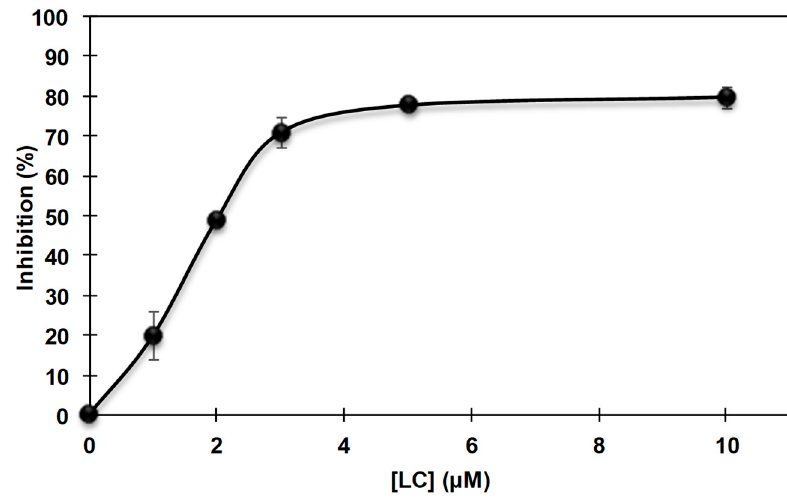
Figure 5. Percent of inhibition of mushroom tyrosinase activity vs. LC concentration using L -tyrosine (1 mM) as the substrate. Reported are the mean ± SD values of at least three experiments.